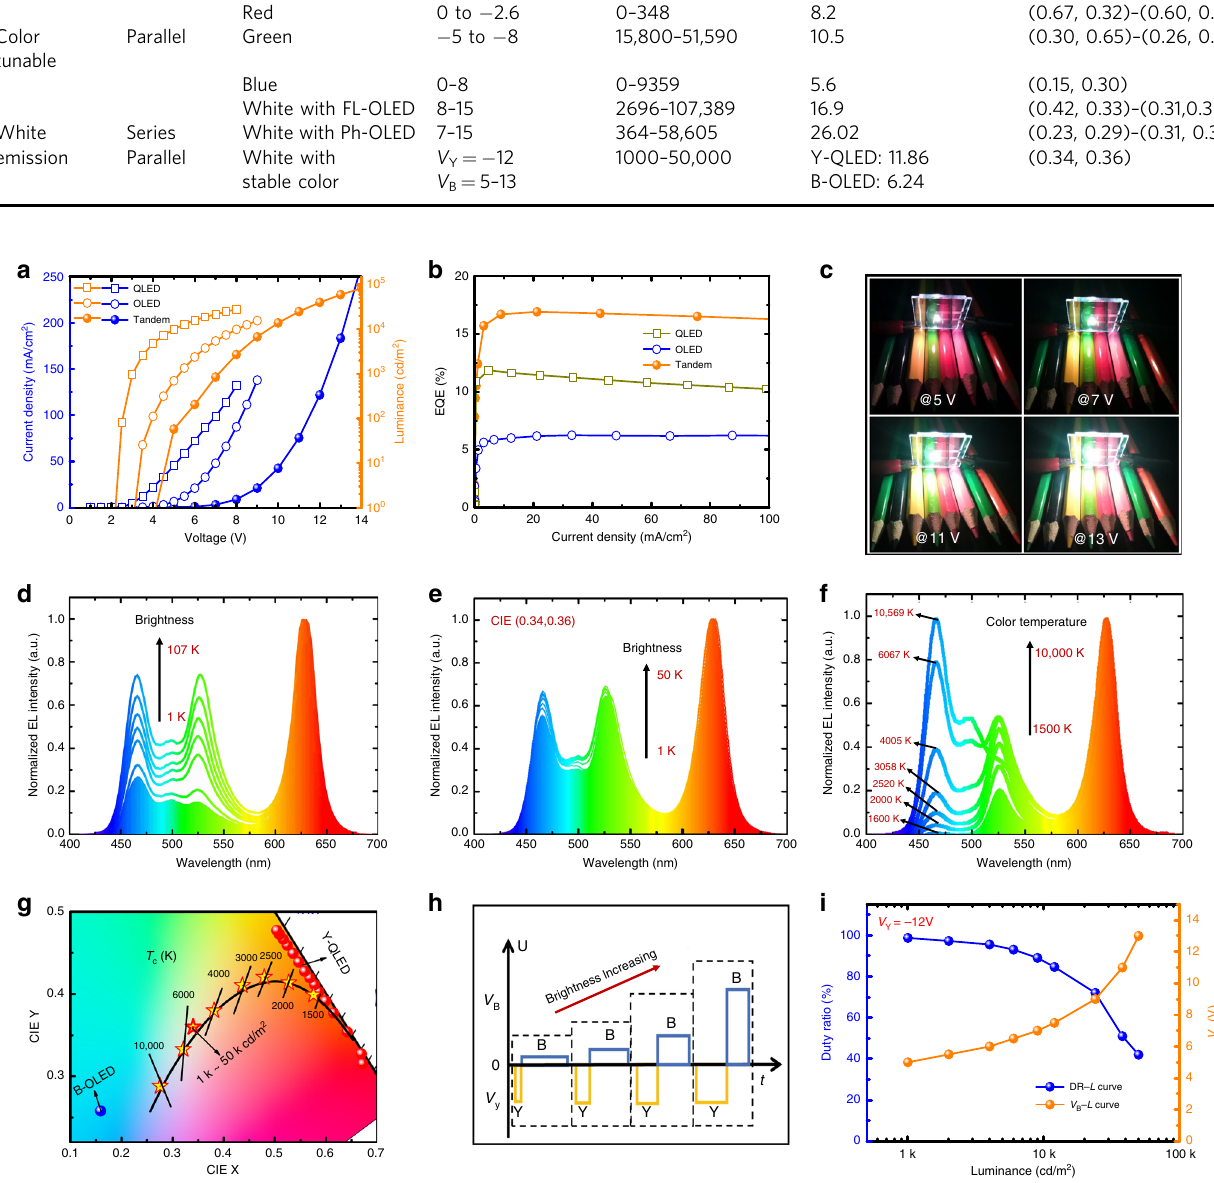
Fig. 4 Performance of the tandem white LED. a The J – V – L , b EQE – J characteristics of the B-OLED, Y-QLED, and tandem white LED. c The photos of an operating tandem white LED driven by different voltage levels. d Normalized emission spectra of the tandem white LED under d DC driving, and e , f AC driving. g CIE coordinates of the white LED (star), B-OLED (blue point), and Y-QLED (red point). Under AC driving, stable white emission with CIE coordinates fi xed at (0.34, 0.36) can be obtained for a wide range of brightness (1000 – 50,000 cd m − 2 ). Also, the color temperature can be tuned from 1500 to 10,000 K, which well traces the blackbody locus. h AC signals and i DR – L and V B – L curves for driving a color stable white peaked at 524 nm is optimized for display purpose, the resultant signals for a color stable white LED. The V Y for controlling the Y- white emission exhibits a low color rendering index (CRI) of only QLED is fi xed at − 12 V to ensure a stable Y emission. In this case, 60, which could be further improved by using G-QDs with redder the brightness of the Y-QLED and B-OLED is controlled by the emission (e.g. 550 nm). Besides stable white emission for a wide DR of the AC signals and the V B , respectively. By gradually increasing V B and decreasing DR (Fig. 4i), a very stable white range of brightness, the white LED can also be tuned to mimic the emission with a brightness increasing from 1000 to 50,000 cd m − 2 blackbody radiation. As shown in Fig. 4f, by varying the V Y and is obtained. As shown in Fig. 4g, the color coordinates are fi xed at the V B , the emission intensity of Y-QLED and B-OLED can be (0.34, 0.36) for a wide range of brightness. The corresponding tuned in a wide range, thereby allowing us to obtain a series of emission spectra are shown in Fig. 4e. Because the QDs have white emission with different ratios of yellow and blue emission relatively narrow emission spectra and the emission of G-QDs intensity. Speci fi cally, the color coordinates of the white LED can